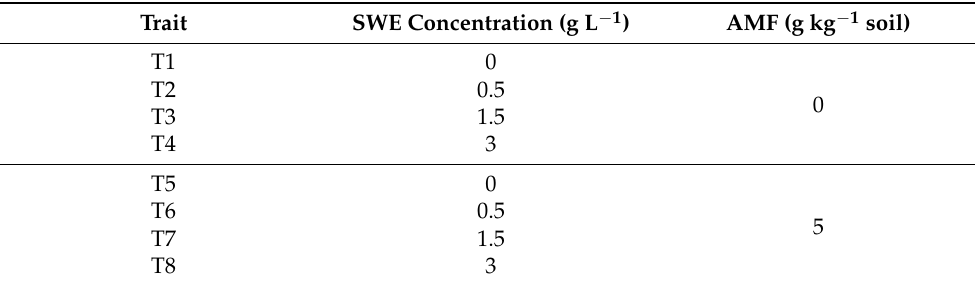
Table 1. The treatment combinations—traits T1–T8.